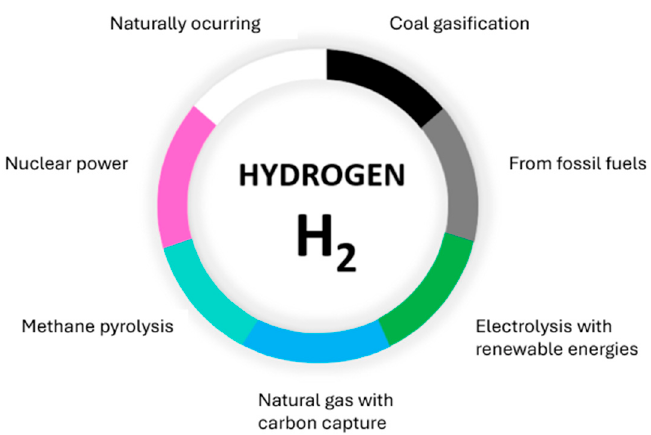
Figure 12. Main hydrogen colors with their respective production methods [48].